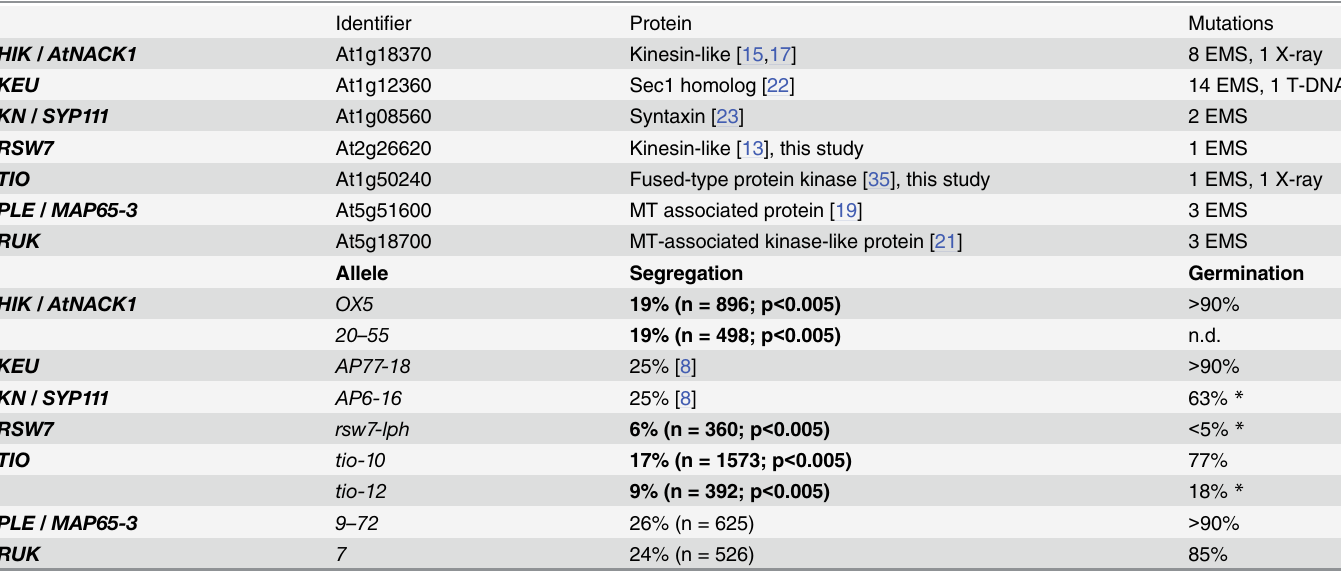
Table 3. Loci mutating to kn-like